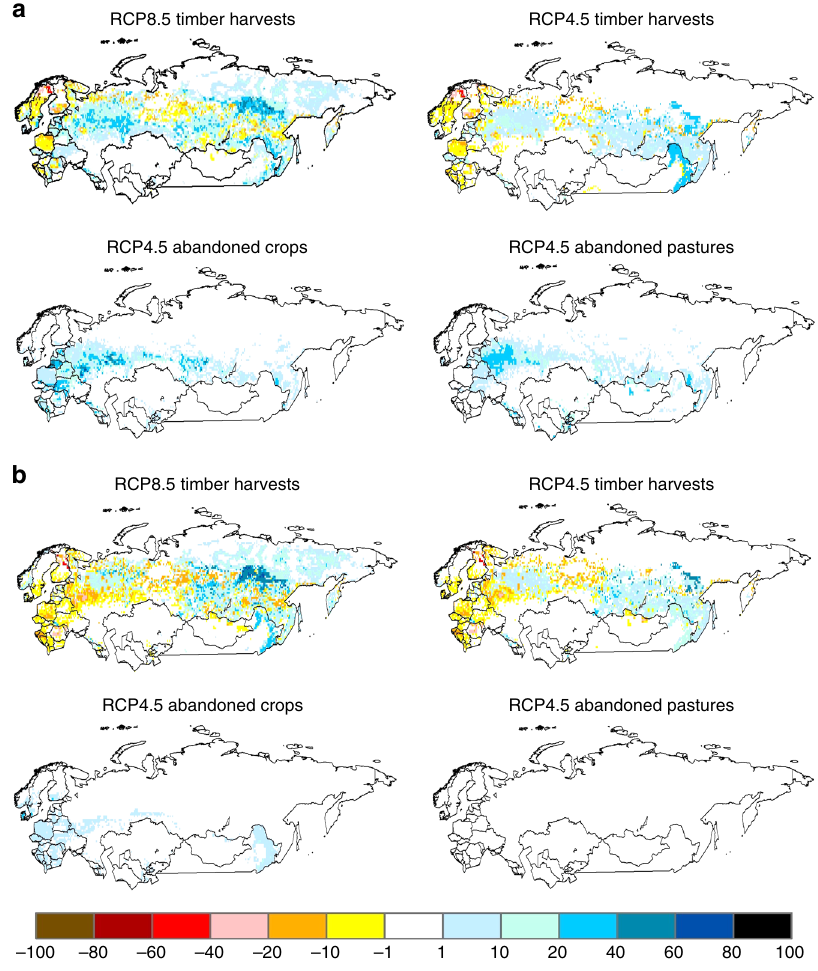
Fig. 7 Spatial patterns of changes in forest cover as in fl uenced by dominant land management under the RCP8.5 and RCP4.5 scenarios over the 21st century. a Changes in percent cover during the fi rst half of the century (2001 – 2050). b Changes in percent cover during the second half of the century (2051 – 2100). Land management includes timber harvests and the abandonment of pastures and fertilized croplands. Positive values indicate an increase in forest area from cropland or pasture abandonment, or an increase in area of young forests (stand age <120-years-old) from timber harvest. Negative values represent a decrease in area of young forests related to forest aging (i.e., stand age becoming older than 120-years-old) from lack of